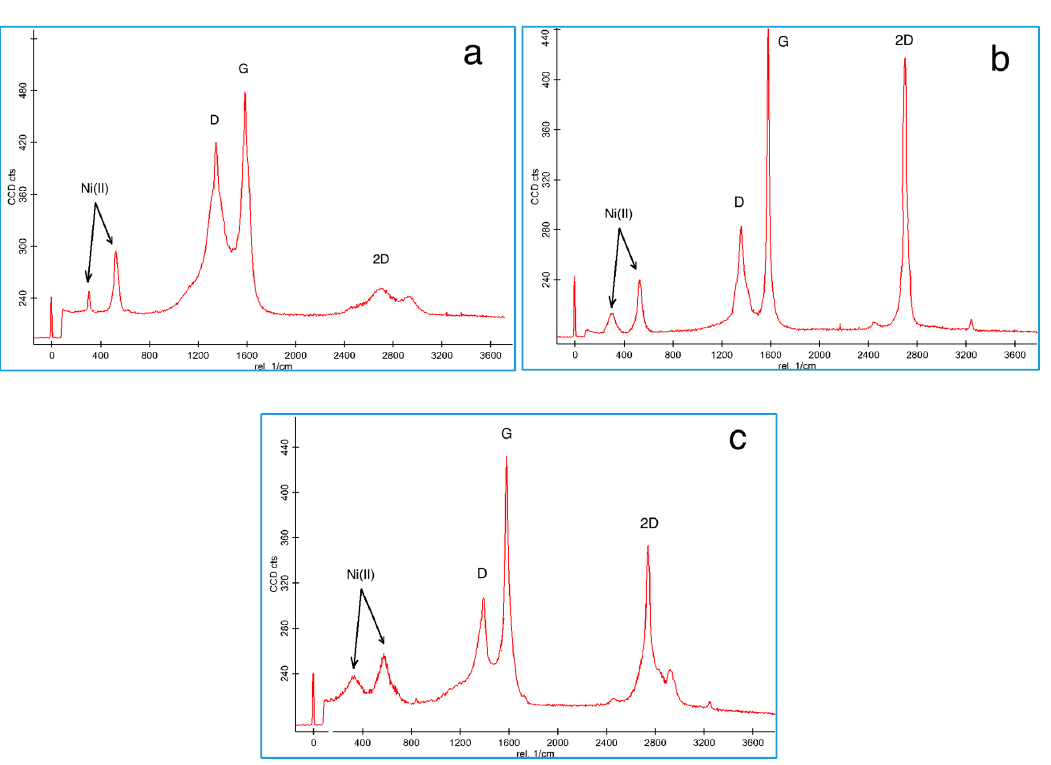
Figure 3. Raman spectra of ( a ) Ni/CNS; ( b ) Ni/CNS-FLG, and ( c ) Ni/CNS-MLG.